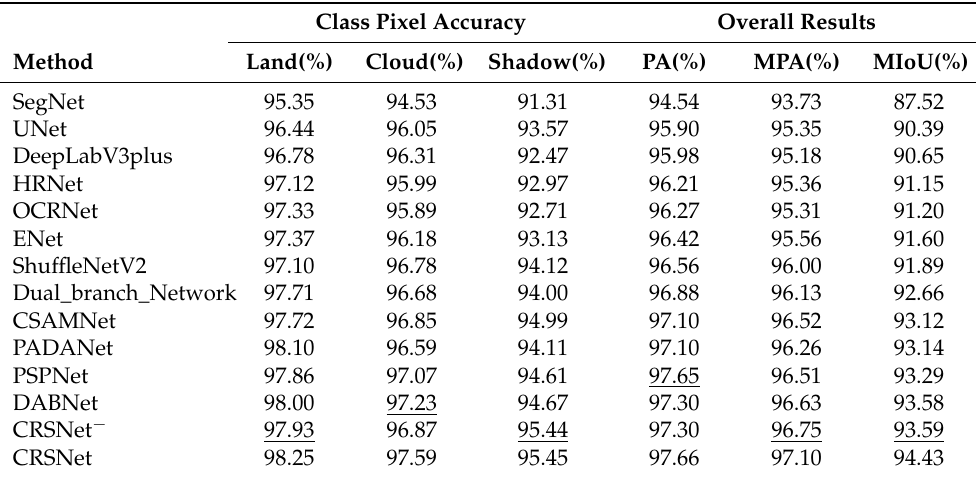
Table 3. Comparison of evaluation metrics of different models on Cloud and Cloud Shadow Dataset. In addition to the overall PA, MPA and MIoU, we calculated pixel accuracy for cloud, shadow and ground, respectively. Symbol “_” indicates no